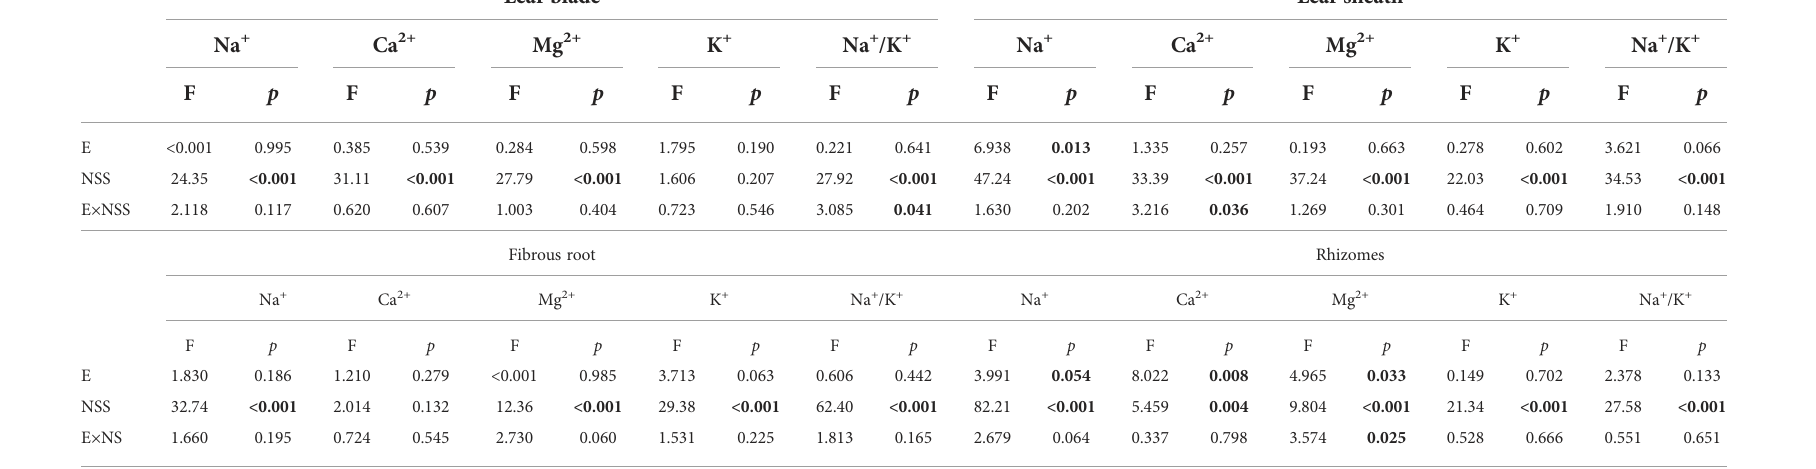
TABLE 5 ANOVA results for the effect of endophyte status and neutral salt stress on ion contents and K + /Na + ratio in shoots and roots. Leaf blade